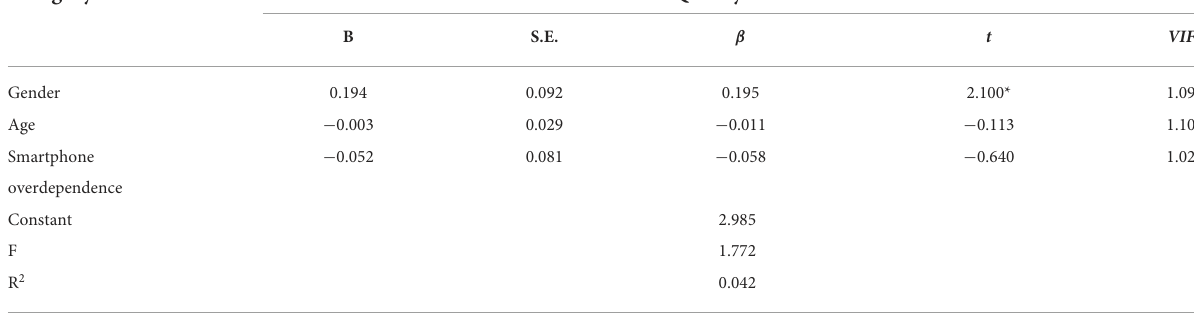
TABLE 4 Relationship between smartphone overdependence and quality of life.